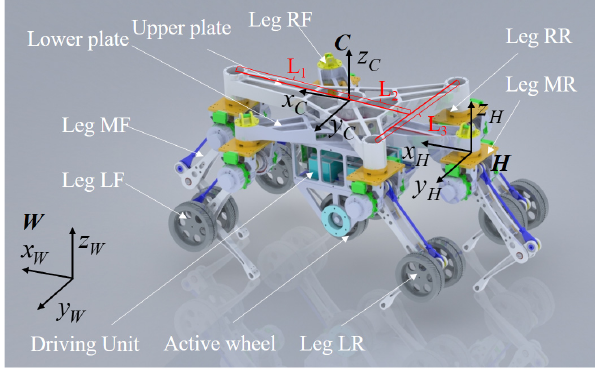
Figure 1. Key coordinate system of the wheel-legged robot. The origin of the torso coordinate system C is at the intersection point of the central axis of the plates and the upper surface of the torso. The axis z c is vertically upward along the central axis of the plates, and the axis x c is horizontally forward along the longitudinal direction of the torso. On that basis, the axis y c is determined via the right-hand-side rule. Moreover, the initial states of each axis of the world coordinate system W and the leg coordinate system H are the same as that of the torso coordinate system C . The origin of H is at the intersection point of the central section of the hip and the axis of the hip pitch joint. Moreover, the structure of a single leg is shown in Figure 2. The leg coordinate system H is at the top of the single leg while the coordinate system L 1 is at the hip of the single leg. The axis z L 1 is along the axis of the first joint of the single leg, and the axis y L 1 is vertically upward. On that basis, the axis x L 1 is determined via the right-hand-side rule. The coordinate system L 2 is at the knee of the single leg and the axis z L 2 is along the axis of the second joint of the single leg. The axis y L 2 and the axis x L 2 are shown in Figure 2. The coordinate system F is at the foot end of the single leg. The axis z F is vertically upward along the normal of the ground. The axis x F and the axis y F are shown in Figure 2. Distances between the coordinate system H and the coordinate system L 1 , the coordinate system L 1 and the coordinate system L 2 , the coordinate system L 2 and the coordinate system F are l 0 = 120 mm, l 1 = 310 mm and l 2 = 290 mm, respectively, which is shown in Figure